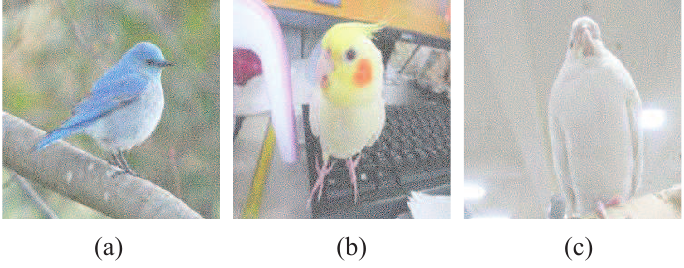
Figure 12. Color meaningful shadows of the proposed ( 3,3 ) -SDIS: ( a ) CS 1 ( b ) CS 2 ( c ) CS 3 . Experiment D. Three color meaningful shadows CS 1 − CS 3 of the proposed ( 3, 3 ) -SDIS sharing a true color secret image are